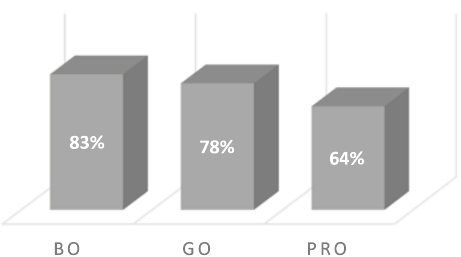
fig. 2. The percentage of participant recognising “diverse considerations with uncertainty” as a